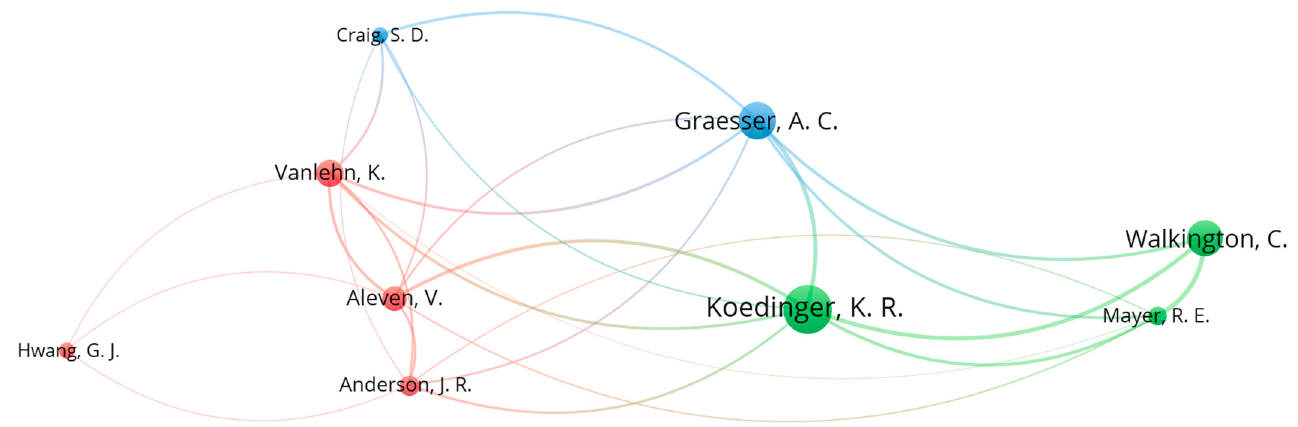
Figure 6. The most cited authors (co-citation analysis).